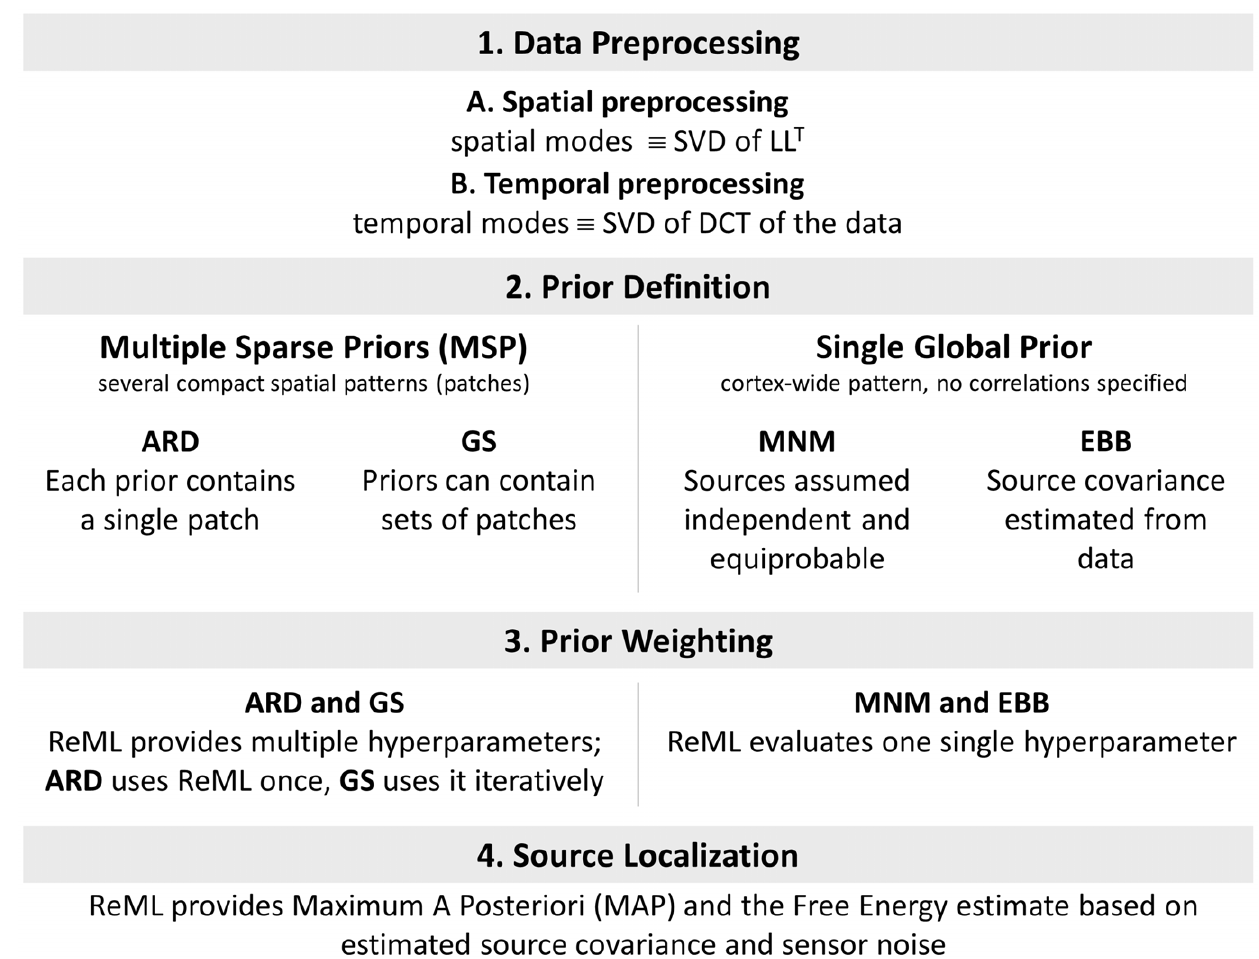
Figure 1. The four common stages for the algorithm comparison. 1. Data preprocessing (common to all schemes) 2. Prior definition (multiple (ARD and GS) or single (MNM AND EBB)) 3. Prior weighting through ReML 4. Source localization (again, common to the four schemes).